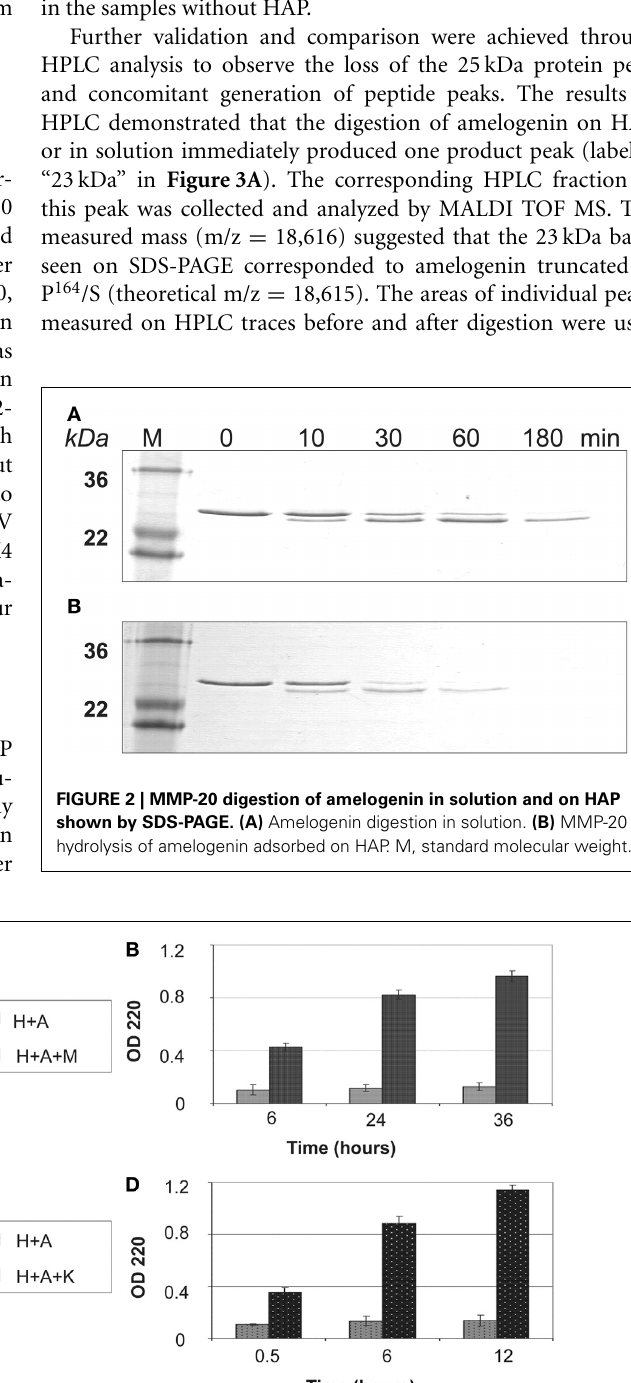
digestion; (C) Protein amounts remained on crystals and (D) released into surrounding supernatant at different time points during KLK4 digestion. H + A, HAP + rh174; H + A + M , HAP + rh174 + MMP-20; H + A + K , HAP + rh174 +